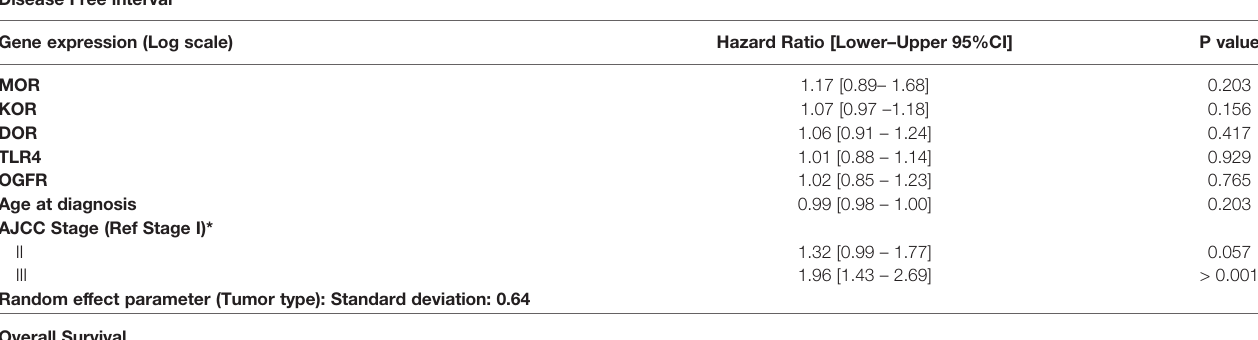
TABLE 3 | Opioid gene expression association with long term oncologic outcomes. Disease Free interval Gene expression (Log